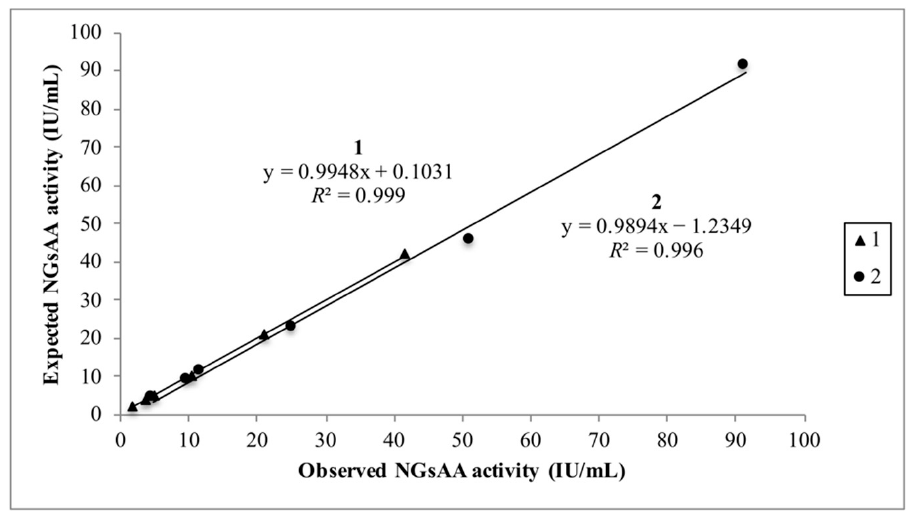
Figure 2. Linearity under dilution in the NGsAA activity measurements after the glycoprotein depletion procedure. A linearity under dilution study was performed in two saliva samples with different NGsAA activities (specimen 1 = 41.87 IU/mL; specimen 2 = 91.44 IU/mL). The x-axis expresses activity or concentration measured and the y-axis expected level at the particular dilution.